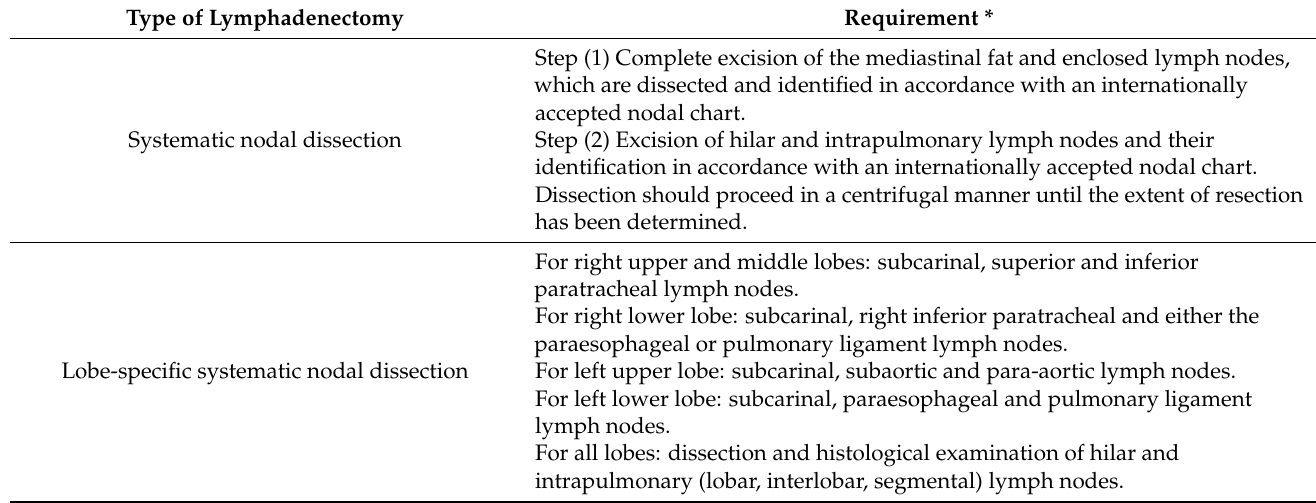
Table 3. Required intraoperative nodal assessment for complete